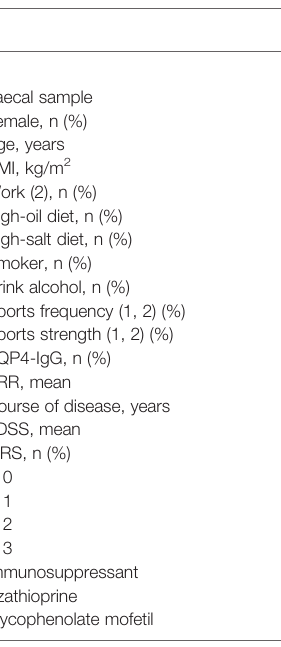
TABLE 1 | Baseline characteristics of the study